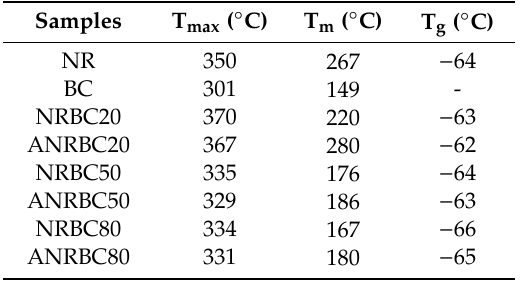
Table 2. Thermal properties of NR, BC, NRBC, and ANRBC films.